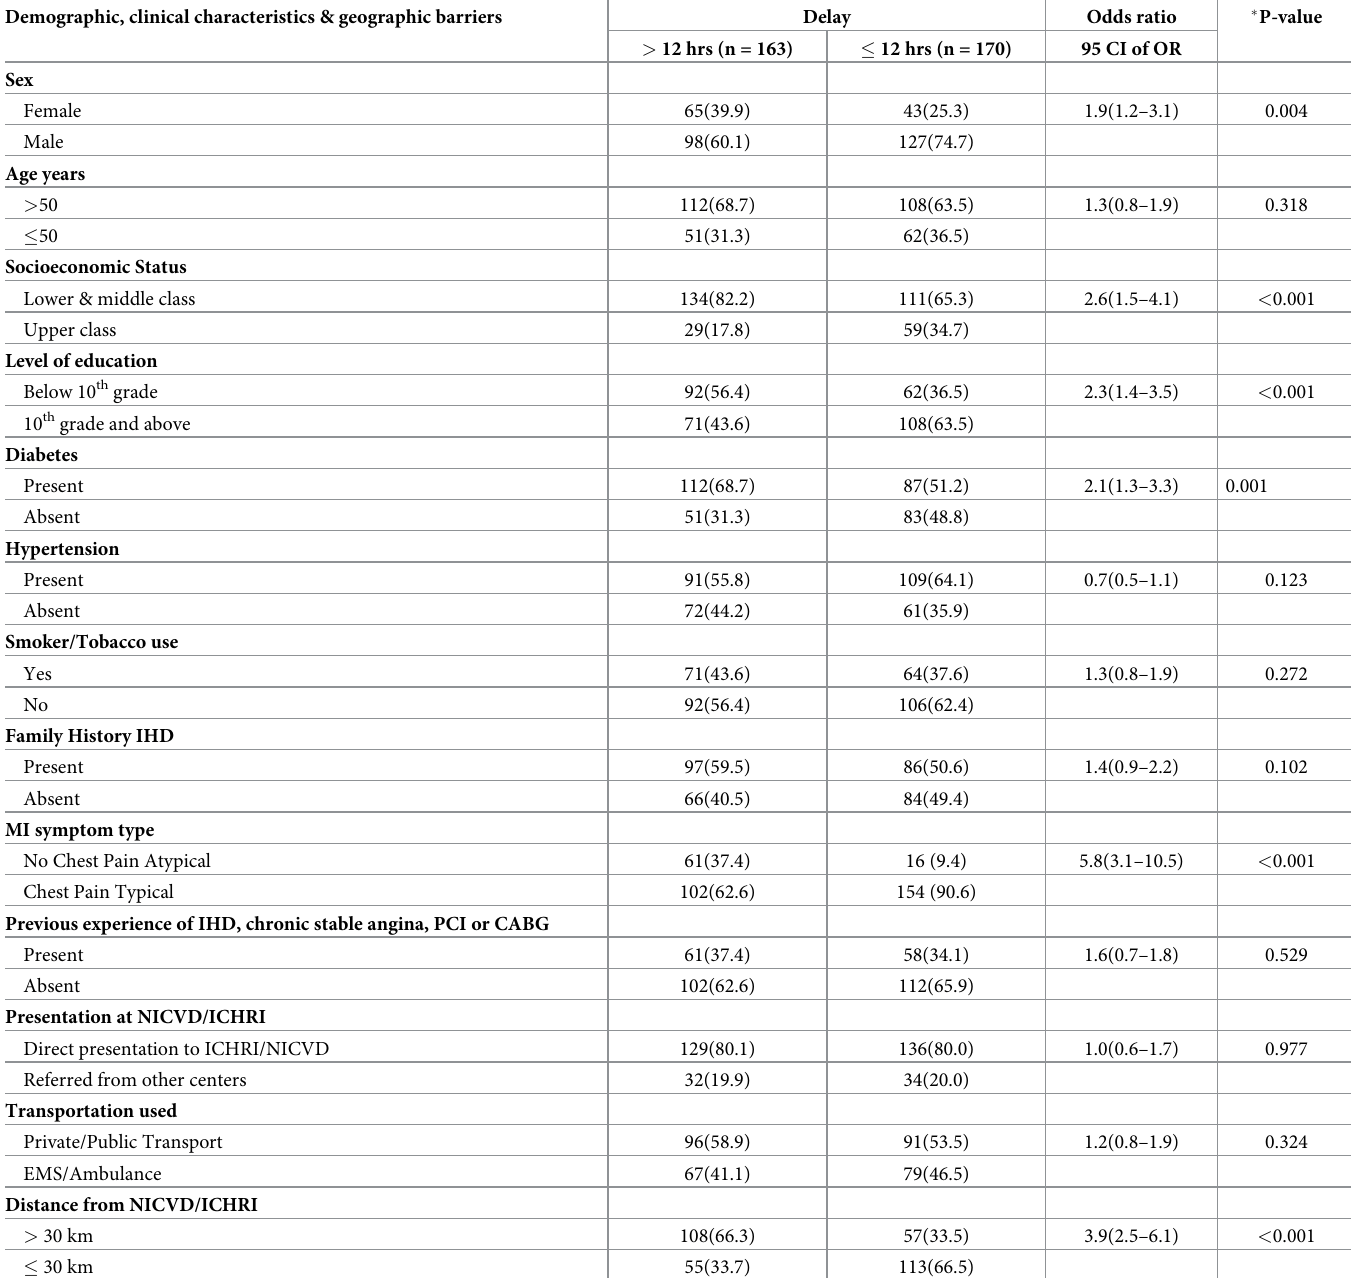
Table 3. Factors associated with pre-hospital delay. Demographic, clinical characteristics & geographic